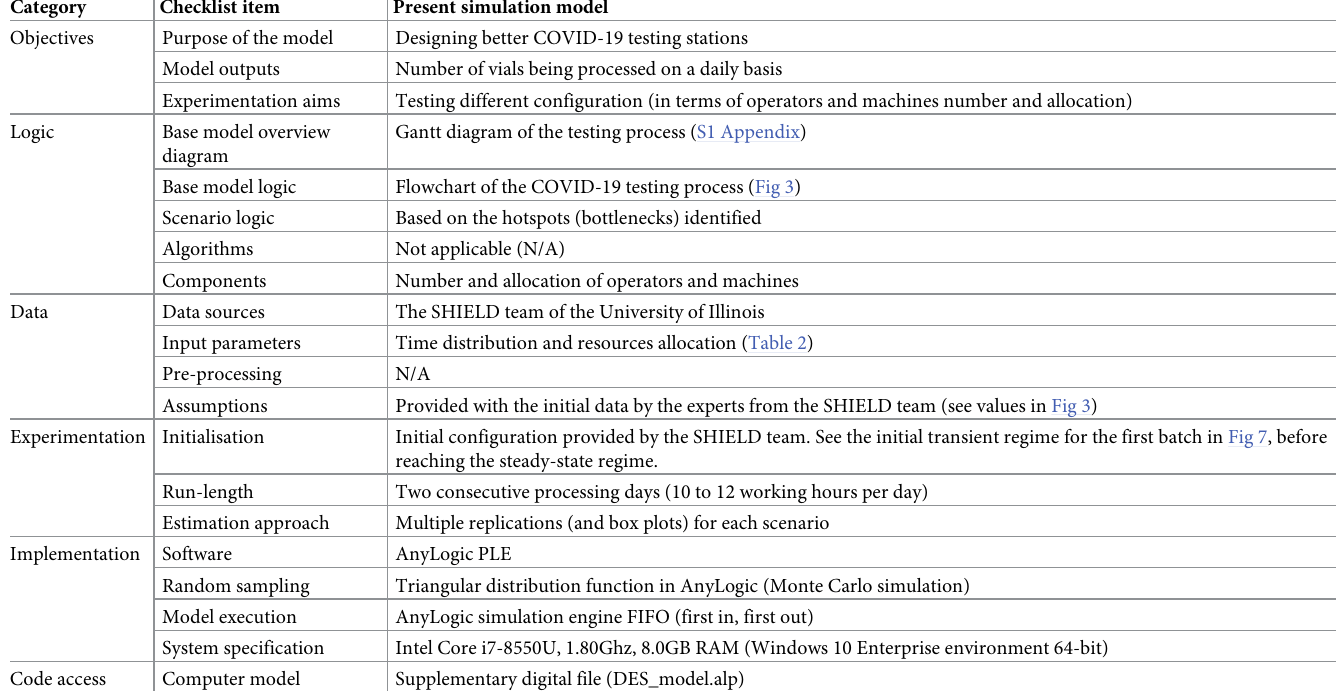
Table 1. Application of the STRESS checklist [38] to the present DES